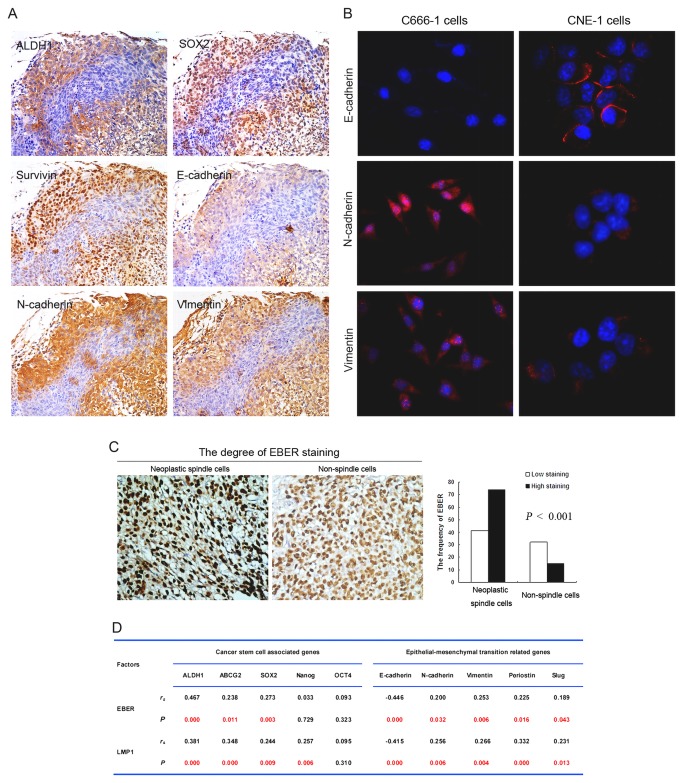
Stem-like spindle cells are strongly associated with EMT -like phenotypic changes and EBV infection.(A) Serial sections from the same patient showed aberrant expression of EMT indicators E-cahderin, N-cadherin and Vimentin in stem-like spindle cells. (B) Spindle-like C666-1 cells had strong fluorescence staining of N-cadherin and Vimentin, and weak staining of E-cadherin compared with epithelial-like CNE-1 cells. (C) Representative images show that high expression (dark brown) of EBV-encoded small RNA (EBER) was observed in neoplastic spindle cells in comparison with non-spindle cells in the same tumor. (D) The significant relationship was found between EBER, EBV-encoded protein LMP1 and CSCs/EMT-related markers. Differences statistically significant at P values <0.05.